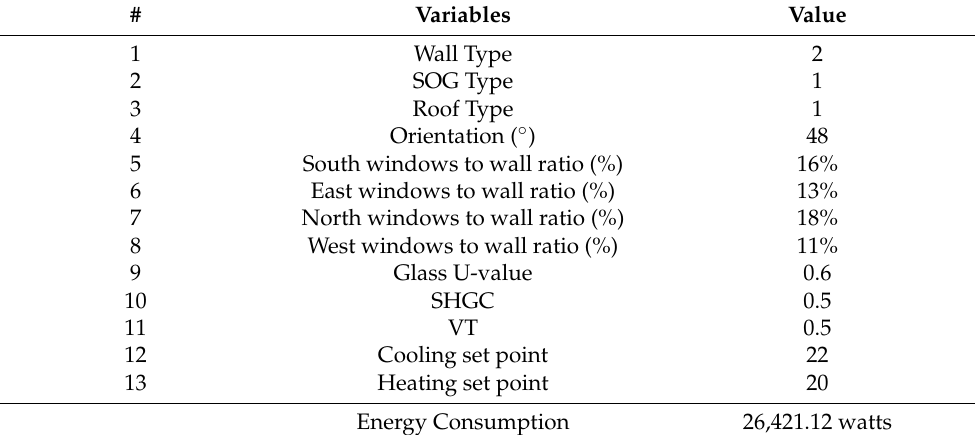
Table 5. The optimum design for the case